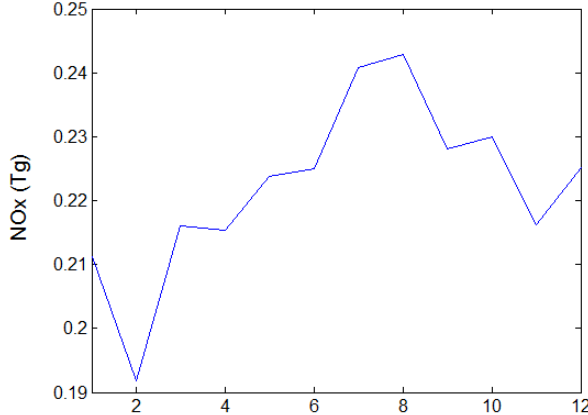
Figure 4. Seasonal distribution of global aviation NO x emissions for